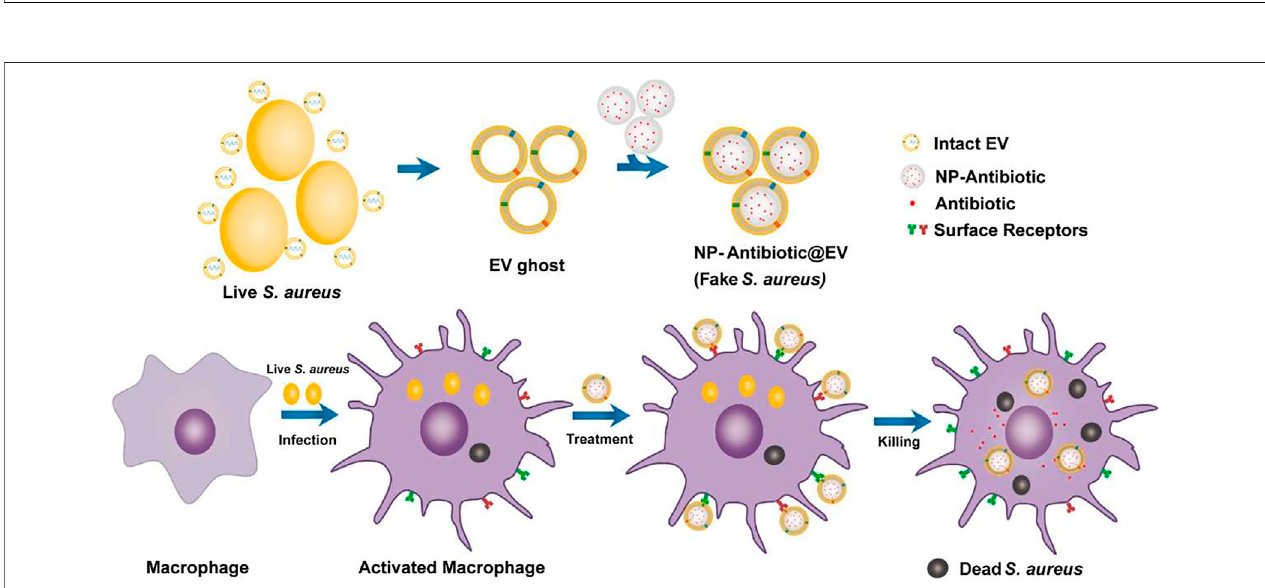
FIGURE 2 | The preparation of nanomedicines by fusing the extracellular vesicles membrane derived from S. aureus (EV ghost) over the surface of a nanoparticle (NP) and their therapeutic process (Gao et al., 2019).